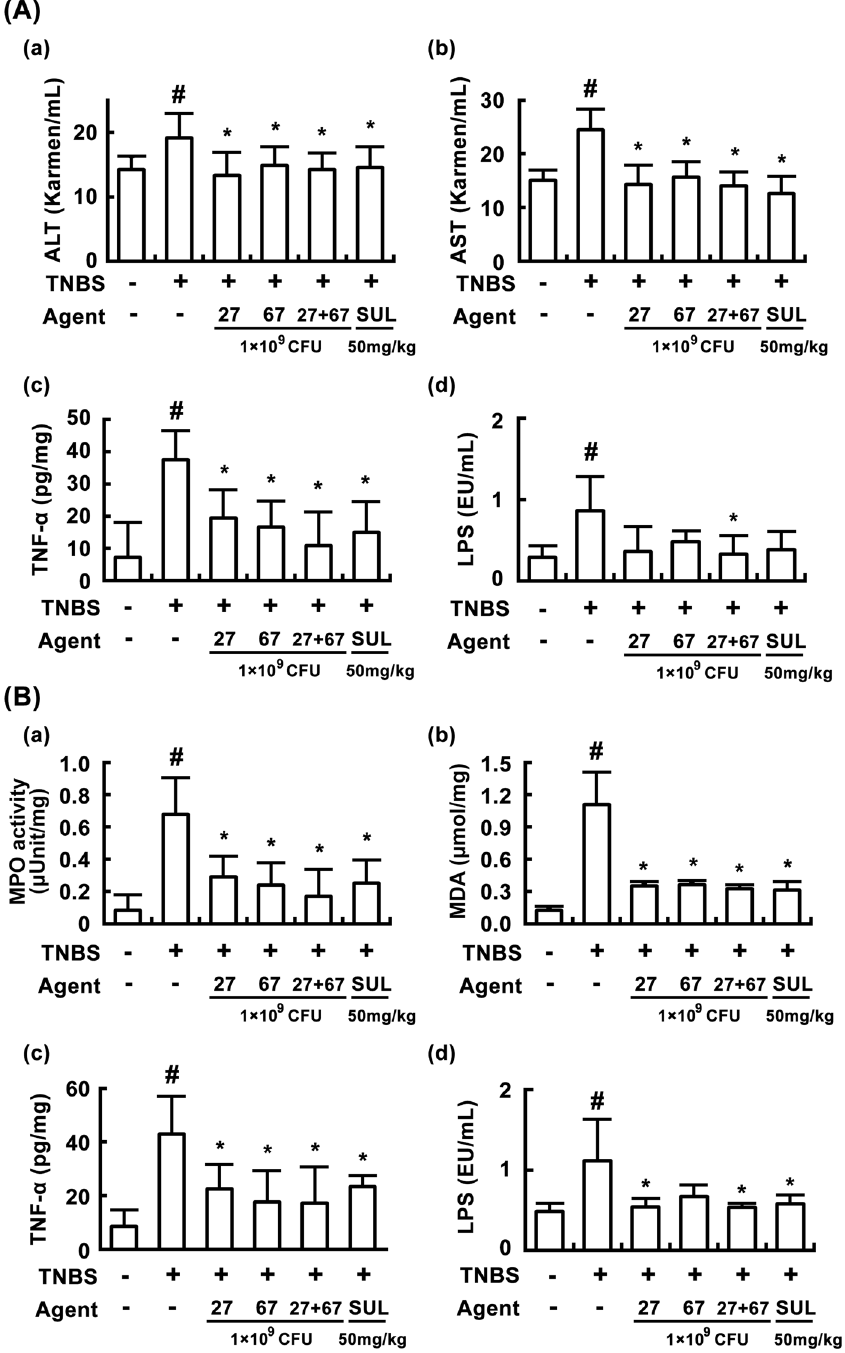
Figure 6. Effects of LC27, LC67, and PM on TNBS-induced liver injury in mice. ( A ) Effects on blood ALT (a), AST (b), TNF- α (c), and LPS levels (d). ( B ) Effects on liver myeloperoxidase (MPO) (a), malondialdehyde (MDA) (b), TNF- α (c), and LPS levels (d). TNBS, except in the normal control group, was intrarectally administered to mice and test agents [saline, LC5, LC27, LC67, LC68 (2 × 10 9 CFU/mouse), or sulfasalazine (SUL; 50 mg/kg)] were orally administered for 3 days. LPS was determined using LAL assay kit. All values are shown as the mean ± SD (n = 6). # p < 0.05 vs. normal control group. * p < 0.05 vs. group treated with TNBS